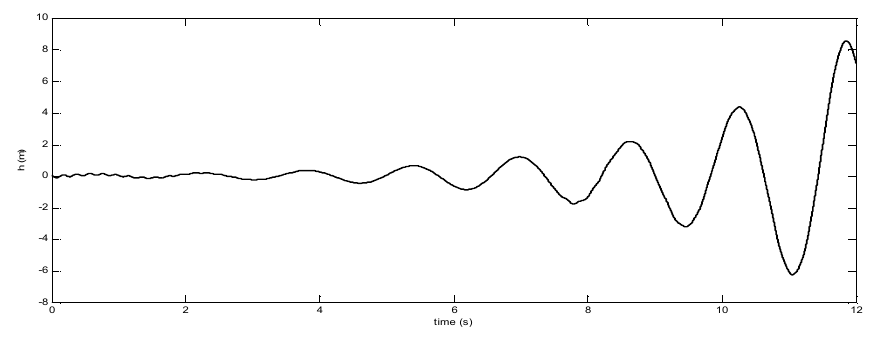
Figure 21. Time response of beta in upper speed of flutter (35 m/s).